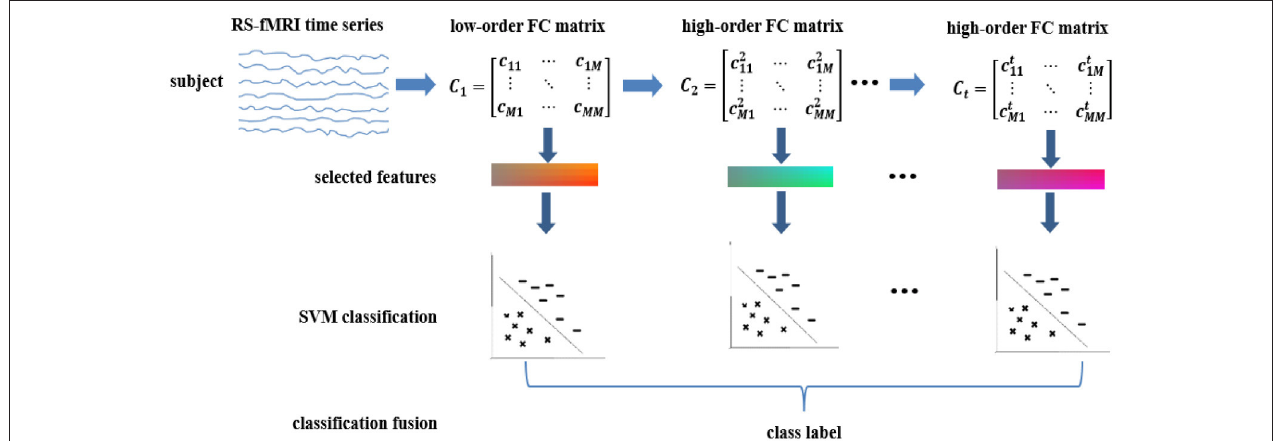
FIGURE 1 | Overview of the proposed multi-level high-order functional connectivity classification framework for ASD diagnosis.